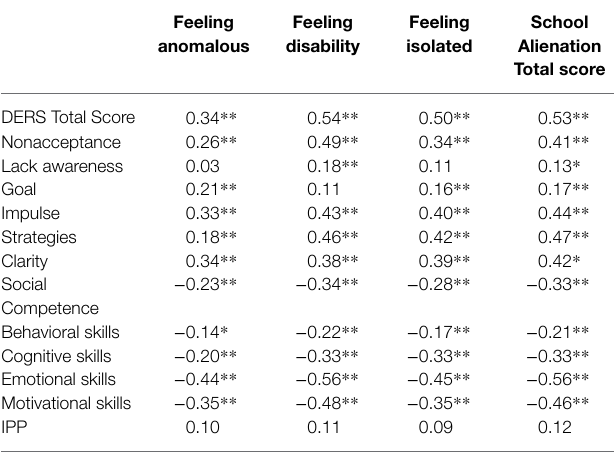
TABLE 2 | Correlations between DERS, SC, IPP, and SL Scores ( n = 280).